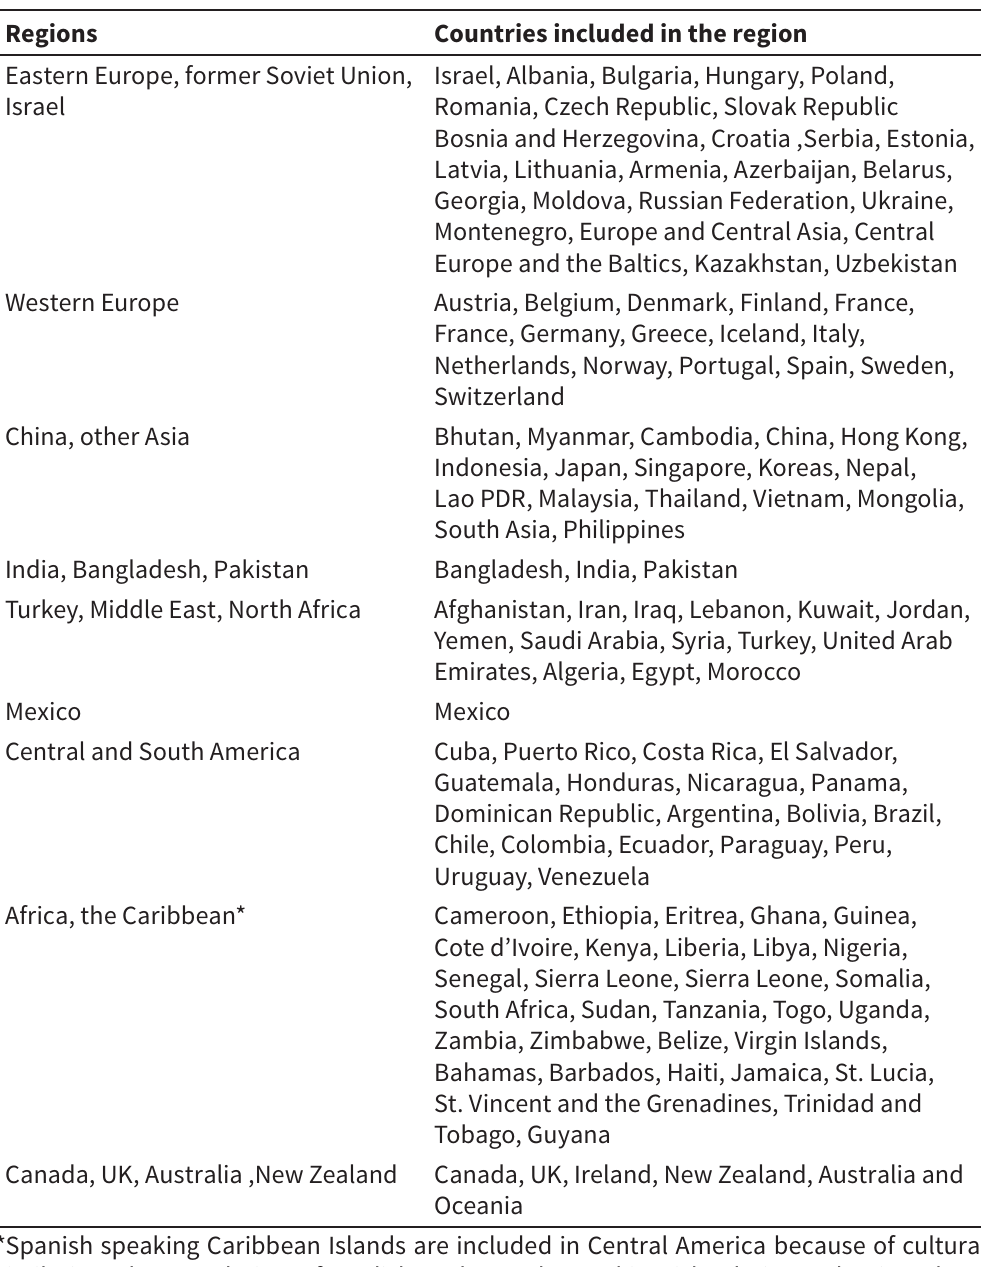
Regions of origin with corresponding countries Regions Countries included in the